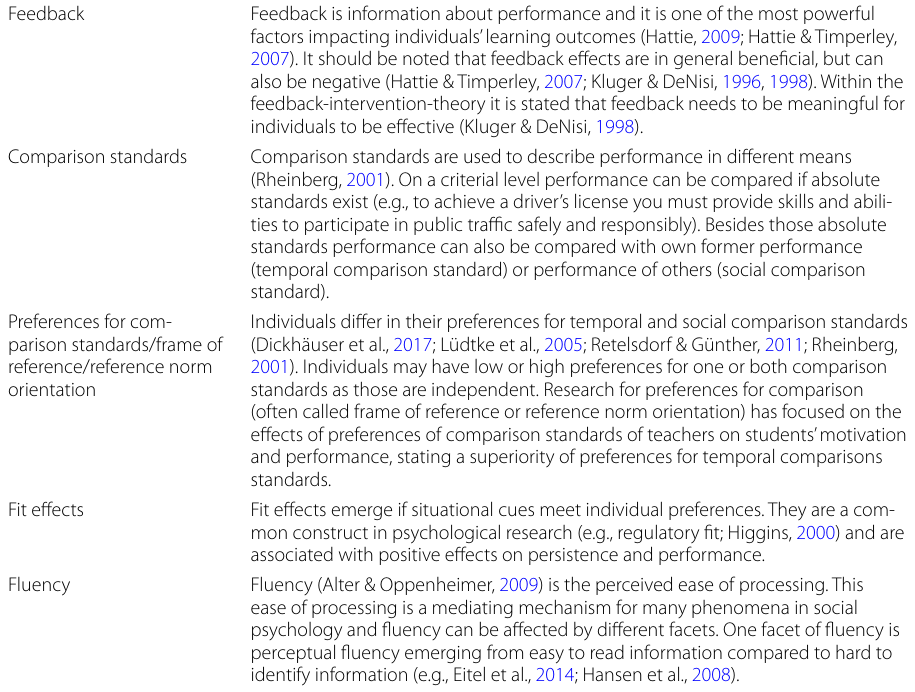
Table 1 Central constructs investigated in this